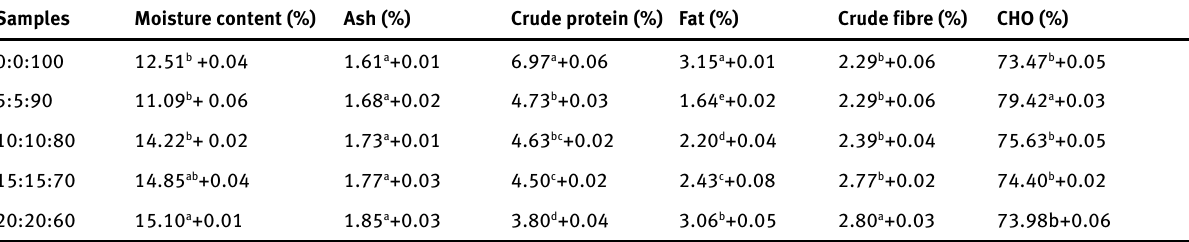
Table 2: Proximate Composition of the Bread samples Samples